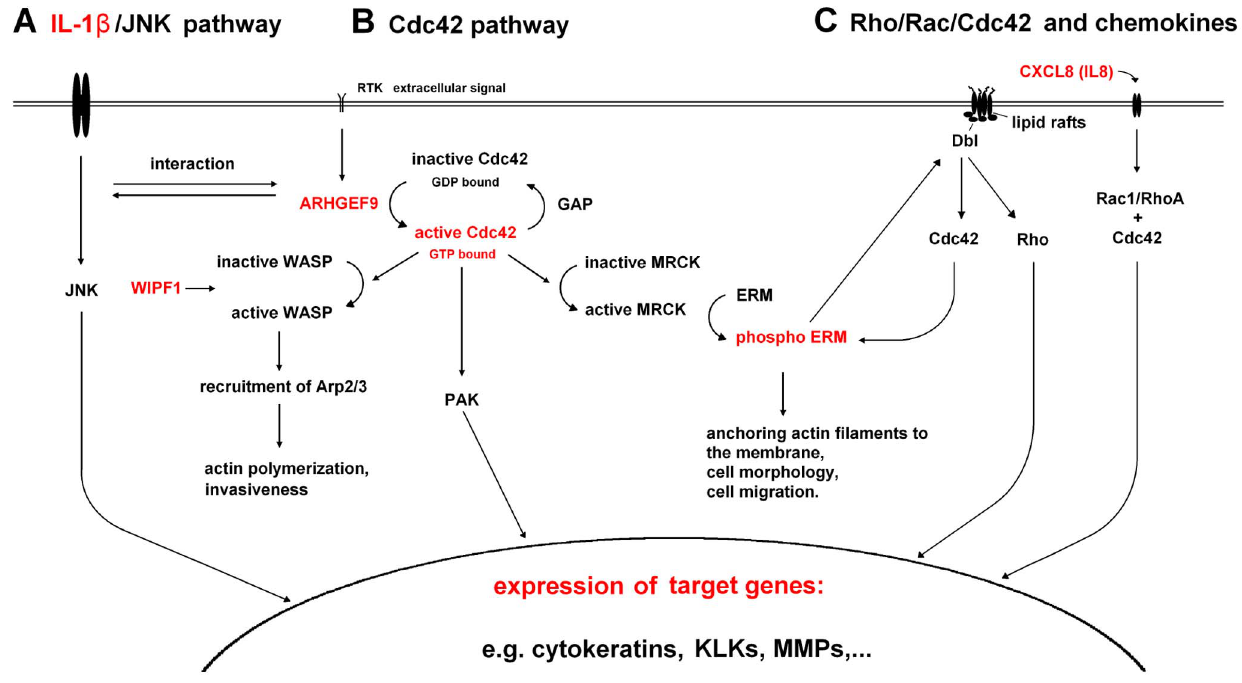
Figure 8. Schematic representation of pathways involved in EBS-DM pathomechanisms. A. IL-1 b activates the JNK pathway in Dowling- Meara cell lines and induces expression of target genes. The IL-1 pathway also interacts with the Cdc42 pathway. B. Schematic representation of the Cdc42 pathway. Upregulation of collybistin (ARHGEF9) leads to increased GDP-GTP exchange and activation of Cdc42. Active Cdc42 activates its downstream effectors like WASP (Wiskott-Aldrich Syndrome Protein) and Arp2/3 (Actin-related protein 2 and 3) as well as MRCK and ERM proteins [41,42,43]. The Arp2/3 complex serves as a nucleation core for actin polymerization, and phospho-ERM proteins connect actin filaments to the plasma membrane. WIPF1 expression was also upregulated in EBS-DM cell lines. The Cdc42 downstream-effects contribute to actin dynamics, invasiveness and, through PAK, to the gene expression levels. C. Depiction of the interconnected network of small GTPases like Rho, Rac and Cdc42 as well as CXCL8/IL-8. Activated Cdc42 leads to increased amounts of phospho-ezrin. After activation, p-ezrin recruits the GEF Dbl to lipid rafts and induces activation of both Cdc42 in a feedback loop as well as the Rho pathway. Binding of CXCL8/IL-8 also leads to activation of Rac1/RhoA and Cdc42, also resulting in expression of target genes. (Red colored items indicate aspects investigated in the present study).